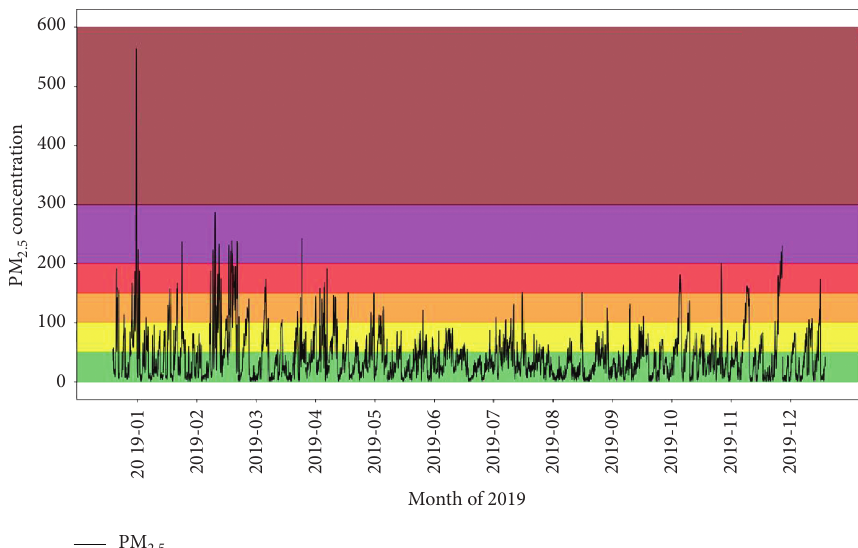
Figure 5: The concentration of PM 2.5 at the Olympic Sports Center monitoring site in 2019.